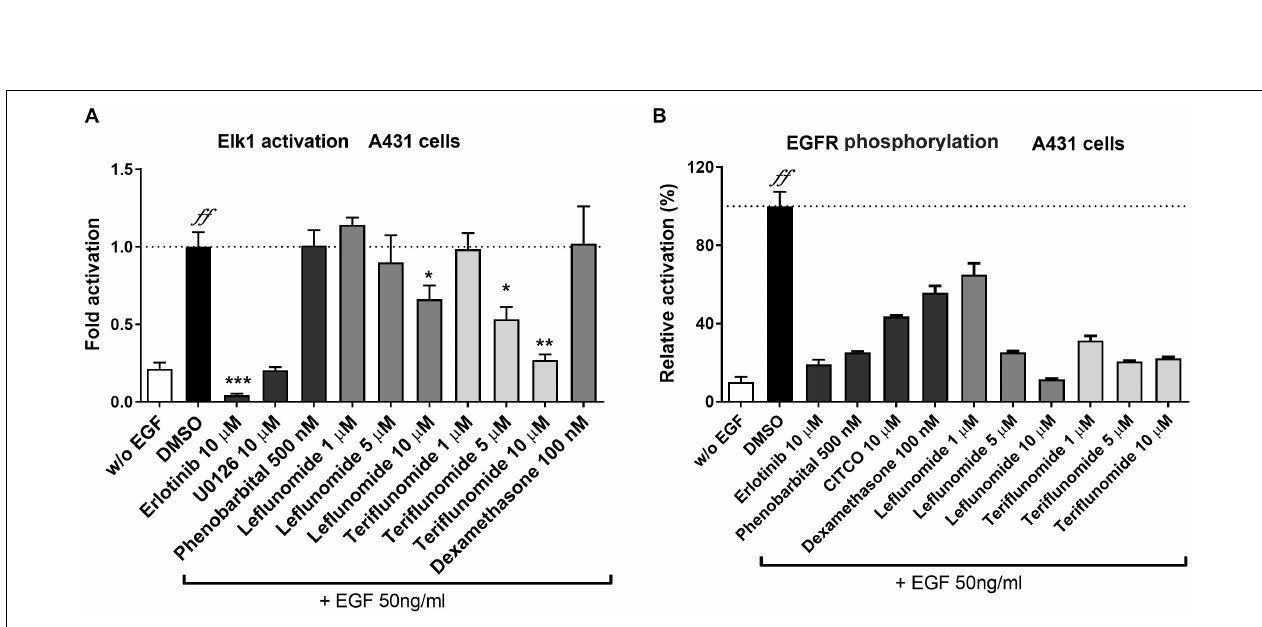
FIGURE 5 | Effects of leflunomide and teriflunomide on ELK1 activation and EGFR phosphorylation in A431 cells. (A) Activation and inhibition of ELK1, a down-stream transcription factor of EGFR signaling, was examined using luciferase gene reporter construct (pGL5-luc, 150 ng/well) and with pFA2-Elk1 plasmid (100 ng/well) in A43. The cells were treated with EGF (50 ng/ml) in combination with LEF and TER (1, 5, and 10 µ M), and the reference compounds erlotinib (an EGFR inhibitor) and U0126 (an up-stream ERK1/2 kinases inhibitor, both at 10 µ M concentration), phenobarbital (500 µ M), dexamethasone (100 nM) and DMSO (1 ) in the control samples for 24 h. Luminescence activity was measured in cell lysate using the Dual Luciferase Reporter Assay. Data are presented as the relative activation of firefly luciferase activity normalized to Renilla and related to the EGF-treated controls, set to 100%. (B) The interaction of LEF and TER with EGFR was (cid:104) tested in A431 cells treated with EGF. Total EGFR and phosphorylated Y1068 EGFR were measured using the sandwich ELISA method according to the manufacturer’s protocol. The A431 cells were pre-treated for 30 min with the tested compounds (concentrations 1, 5, and 10 µ M), erlotinib (10 µ M), phenobarbital (500 µ M), CITCO (10 µ M) and DMSO (0.1%), and then treated with EGF (50 ng/ml) for an additional 10 min. The signal of the phosphorylated protein was normalized with the total EGFR protein, and the background signal was subtracted. The data are expressed as the relative activation related to the cells treated only with EGF (set to be 100%). Data are presented as the mean ± SD of three independent assays ( n = 3). ∗ P < 0.05, ∗∗ P < 0.01, ∗∗∗ P < 0.001 – statistically significant difference compared to the control vehicle- and EGF-treated cells; ff P < 0.01 – statistically significant effect of EGF compare to cells without (w/o) EGF treatment (ANOVA with Dunnett’s post hoc